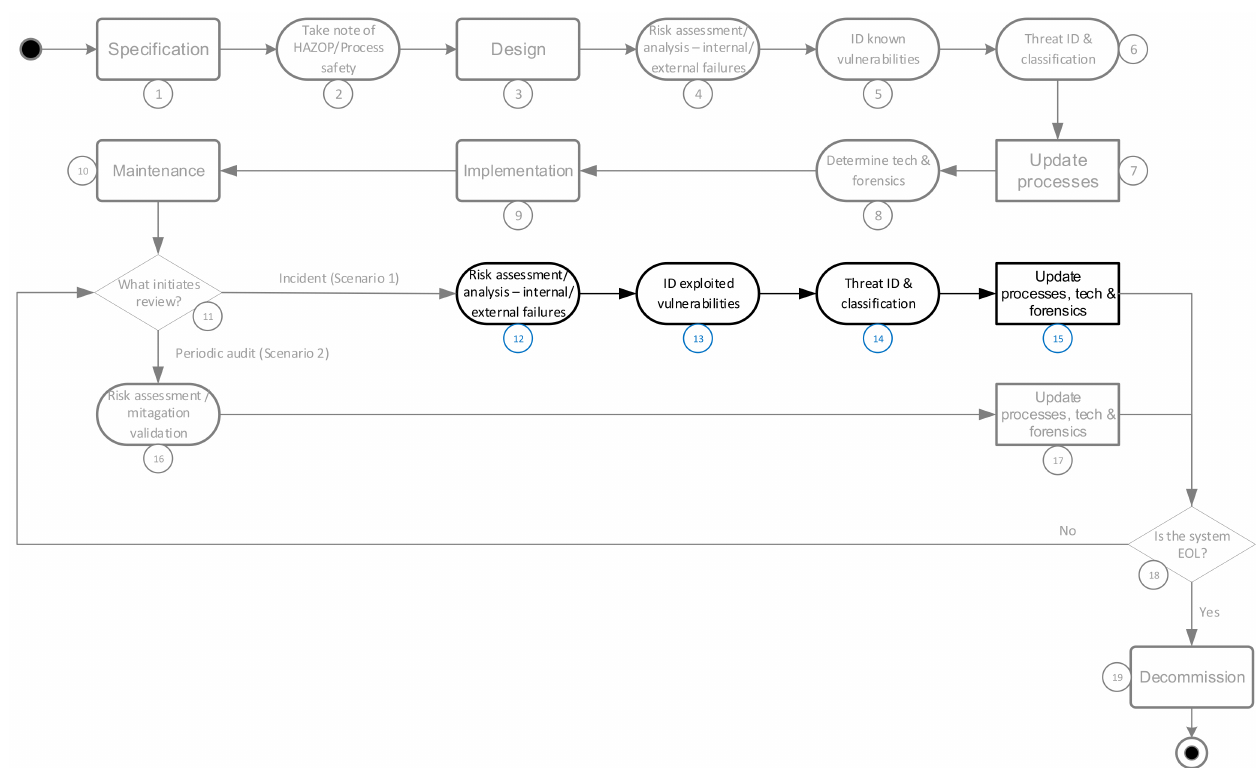
Figure 14. Harmonized taxonomy and case study